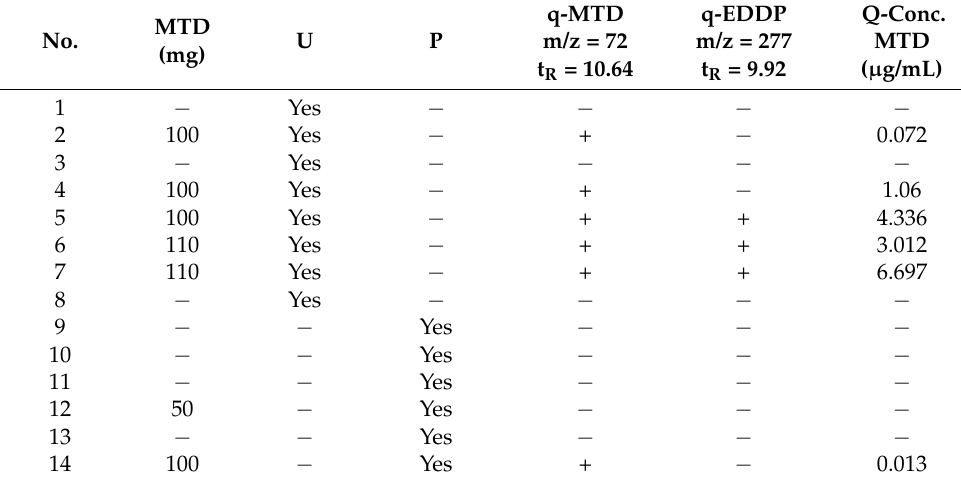
Table 3. Determination of methadone levels in urine and